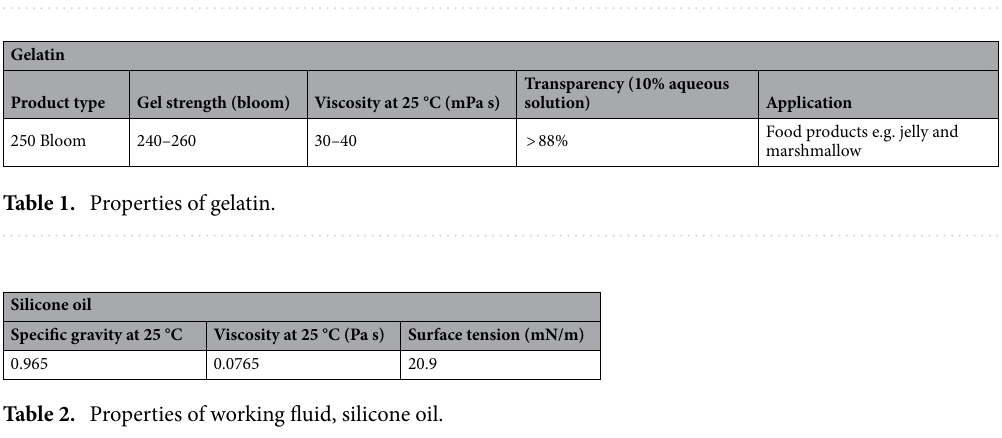
Figure 1. Gelatin treatment of non-crimped unidirectional glass fiber mat.